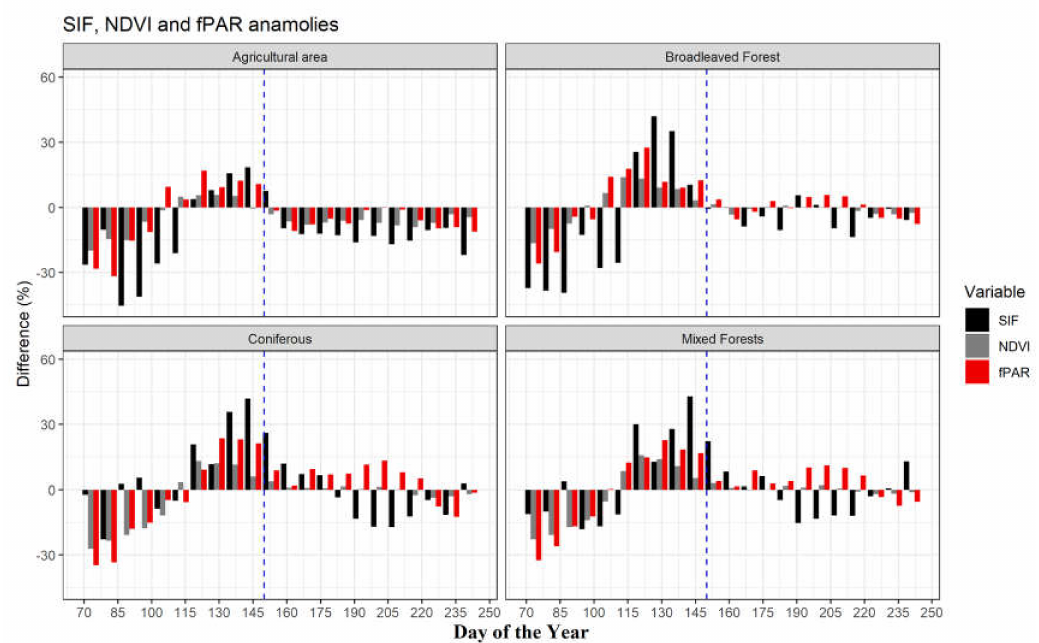
Figure 6. Anomalies (in % di ff erence from “Mean”) of SIF, the Normalized Di ff erence Vegetation Index (NDVI), and fPAR for drought area across di ff erent vegetation types as observed from the Orbiting Carbon Observatory-2 (OCO-2) SIF, MODIS NDVI product (MOD / MYD13Q1) version 6, and MODIS fPAR product (MYD15A2H) version 6 in 2018. Positive values indicate a surplus of SIF, NDVI, and fPAR, negative values indicate lower values in comparison to the mean in 2015–2017. The left and right side of blue vertical dashed line represents spring and summer season,